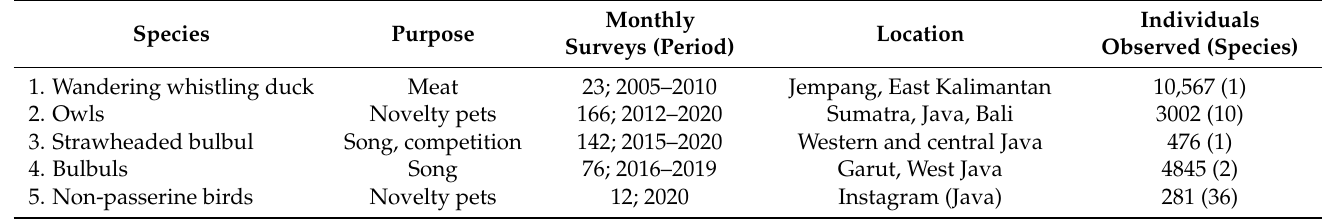
Table 1. Summary of the studies. Monthly surveys are defined as visits to a specific market that are temporarily separated by at least one month; surveys in Garut were